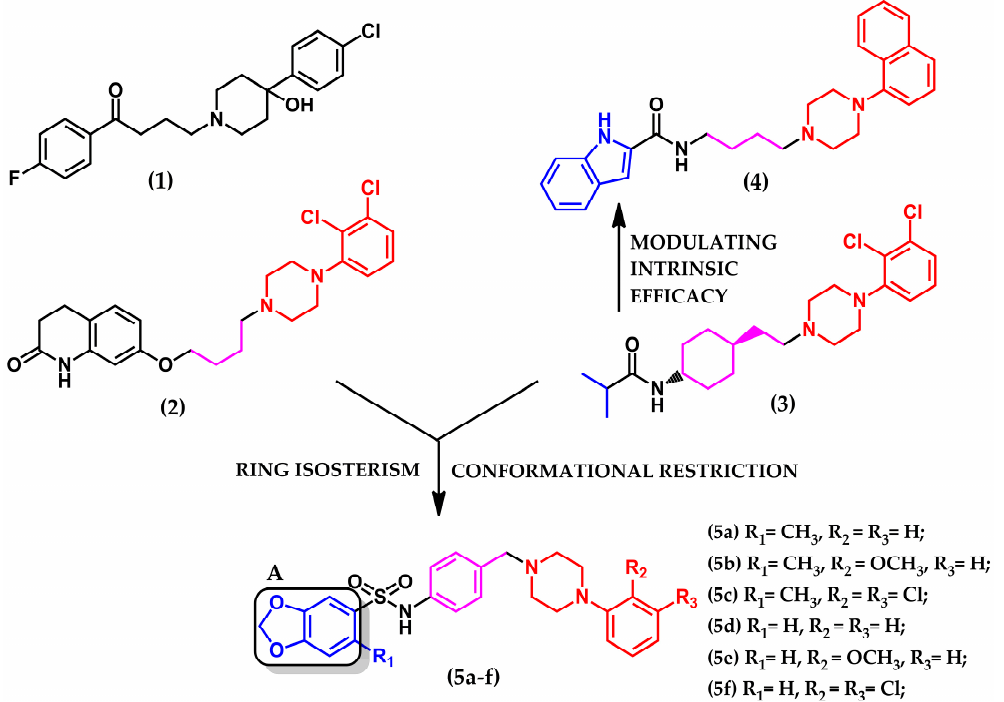
Figure 1. Compounds acting on D 2 and D 3 receptors: haloperidol ( 1 ), aripiprazole ( 2 ), cariprazine ( 3 ) and indole derivative ( 4 ). Design concept of a new series of conformationally restricted N -phenylpiperazines ( 5a – f ).